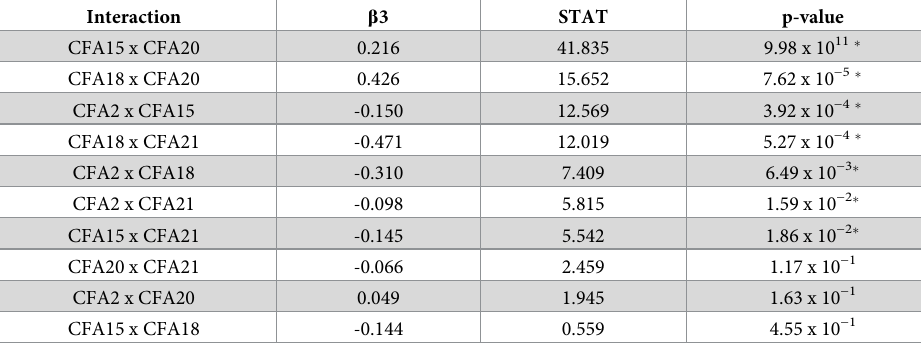
Interaction term coefficients ( β 3), test statistic, and p-value for each pair of the top five GWAS variants. Interactions with a p-value < 5 x 10 − 2 (marked with an asterisk) were considered statistically